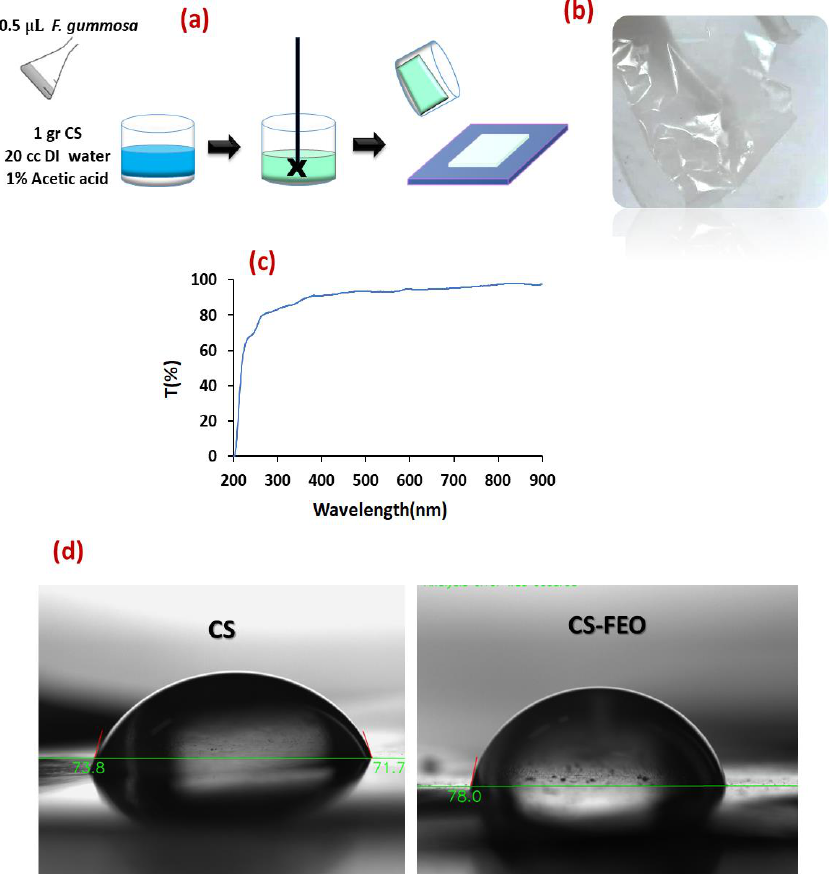
Fig. 6. (a) The schematic image of the preparation process of the FEO-CS biopolymer, (b)Visual transparency of the flexible FEO-CS biopolymer, (c) The transmittance spectrum of the prepared biopolymer, and (d) Contact angle of the CS and FEO-CS nanocomposite films.